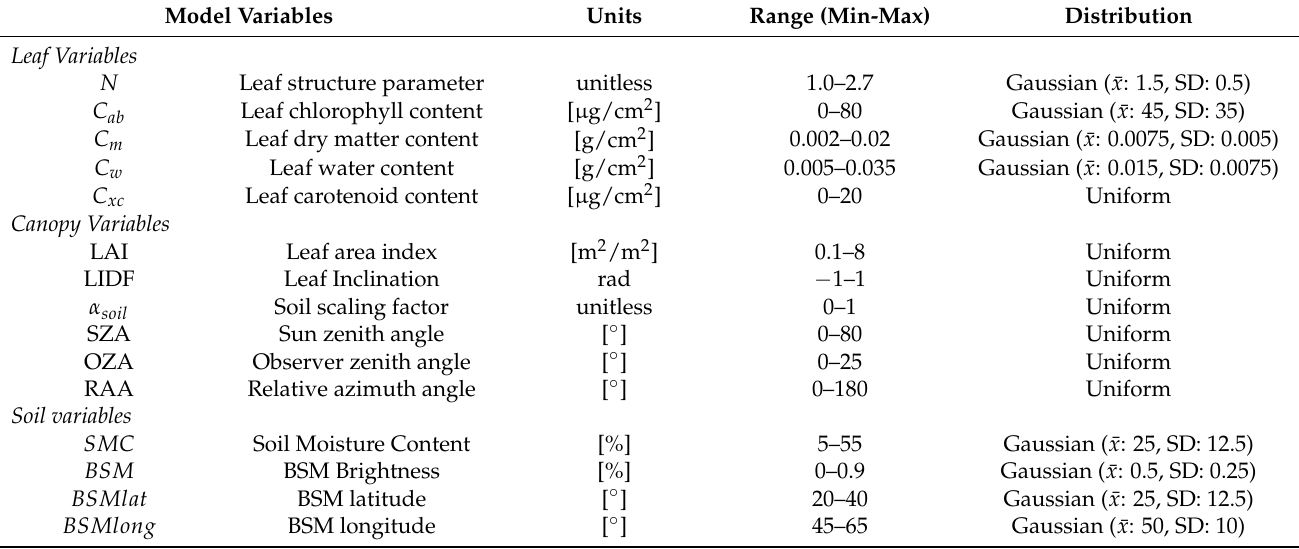
Table 1. Parameterization of SCOPE and BSM soil reflectance models, with notations, units, ranges and distributions of inputs used to simulate the spectral training database. ¯ x : mean, SD: standard deviation.